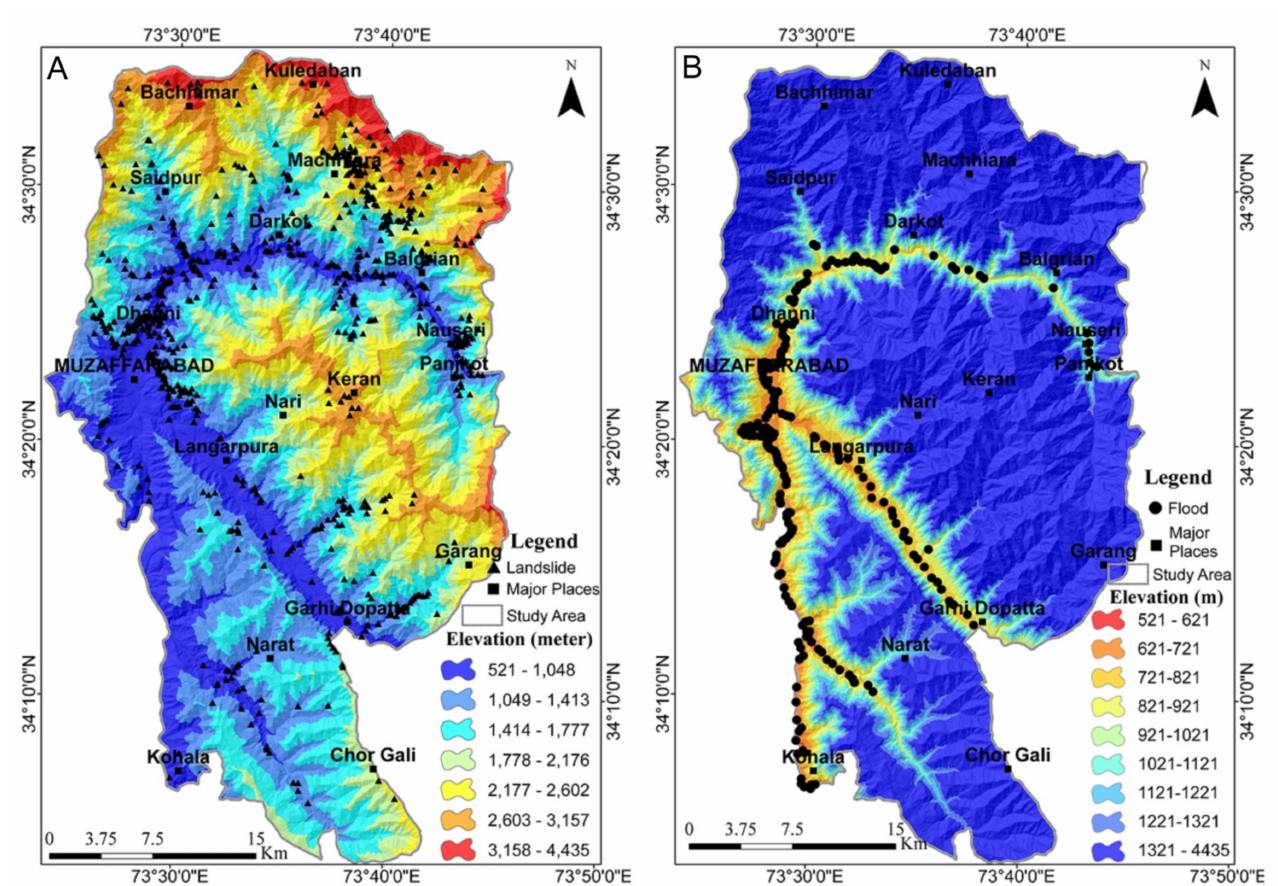
Figure 4. Elevation causative factor maps: ( A ) landslide and ( B )